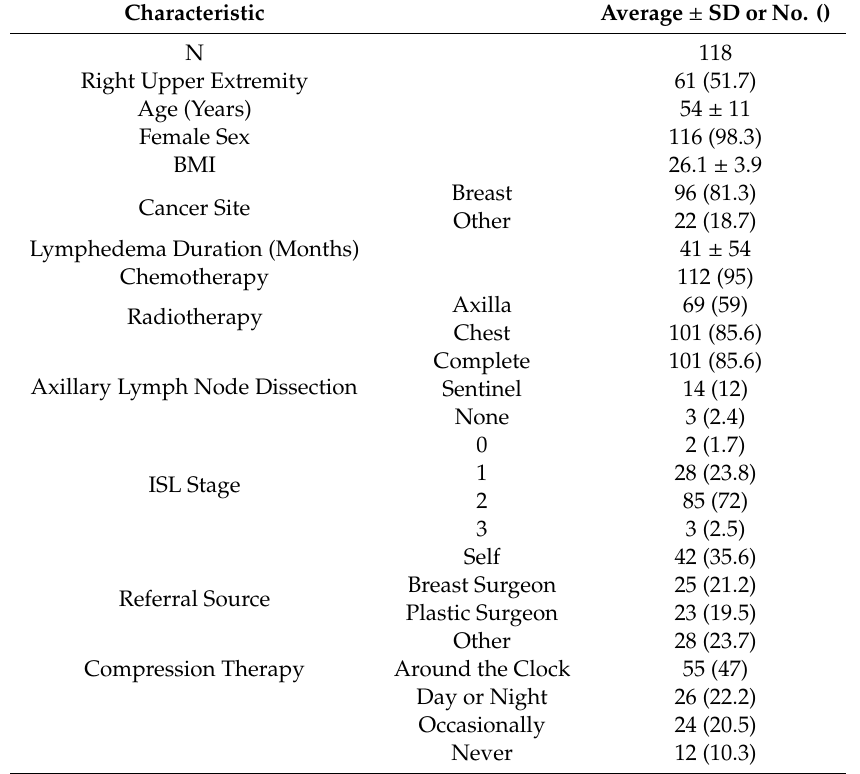
Table 1. Baseline characteristics of patients presenting with upper extremity secondary